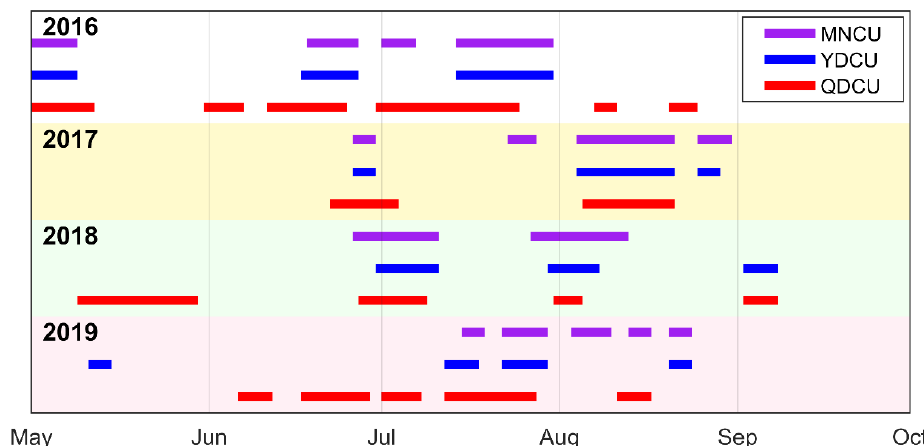
Figure 5. Time series of significant upwelling events in summers of 2016–2019. Purple (blue/red) bars represent the upwelling events off Minnan (Yuedong/Qiongdong) coast. The length of a bar indicates the duration of the event. Purple: Minnan coastal upwelling (MNCU), blue: Yuedong coastal upwelling (YDCU), red: Qiongdong coastal upwelling (QDCU).